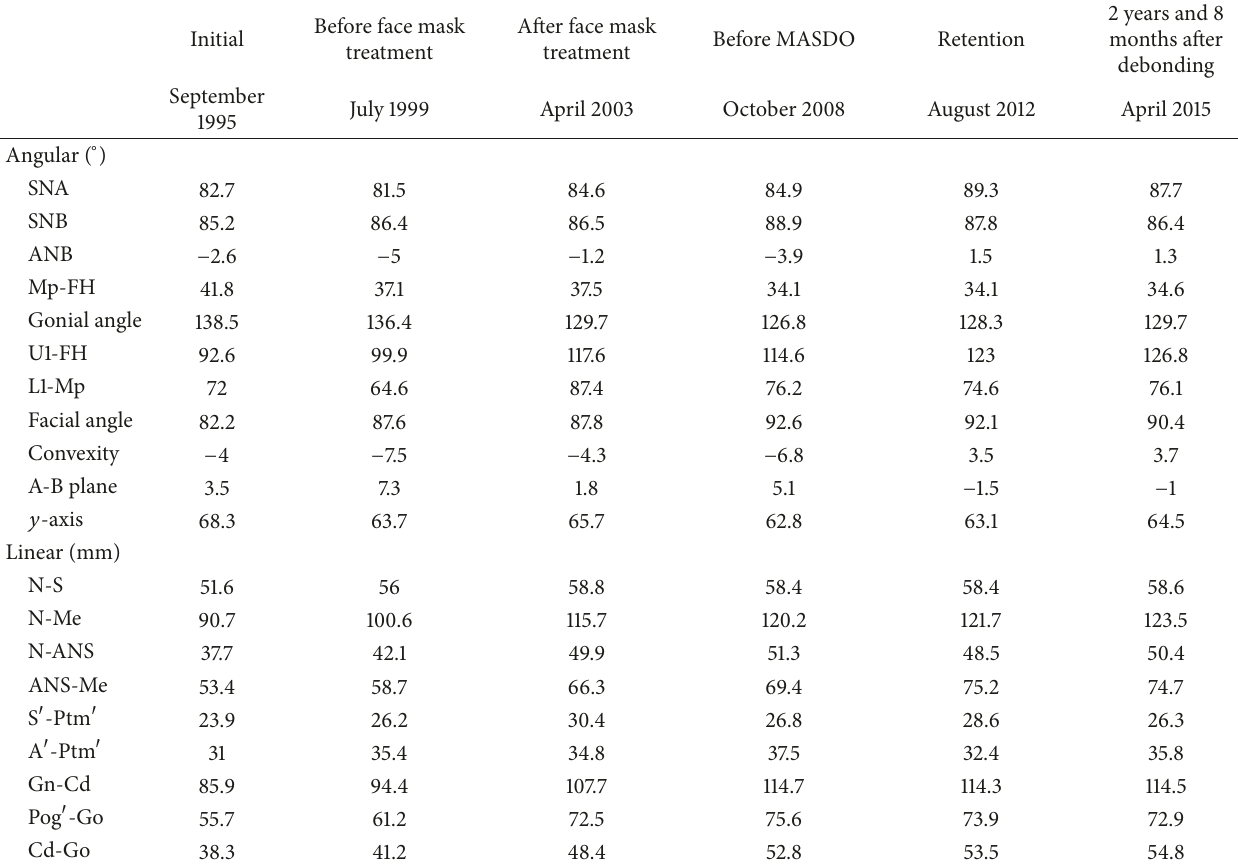
Table 1: Cephalometric analysis at various stages of treatment.